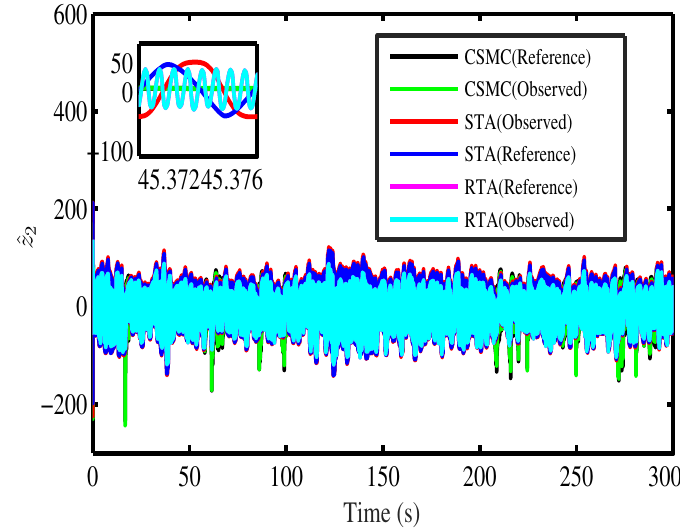
Figure 5. Z 2 tracking in the nominal